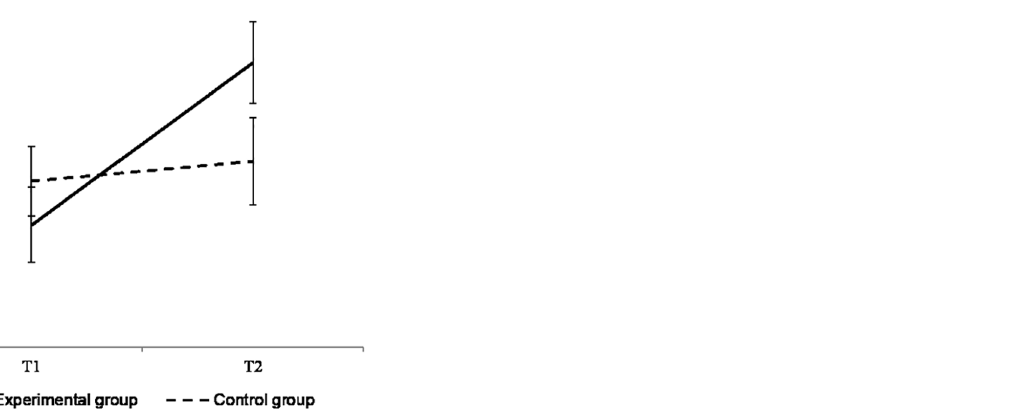
Figure 4. Interaction between time (T1 and T2) and group (Experimental and Control) for the span measure in the Odd One Out task. Error bars represent standard